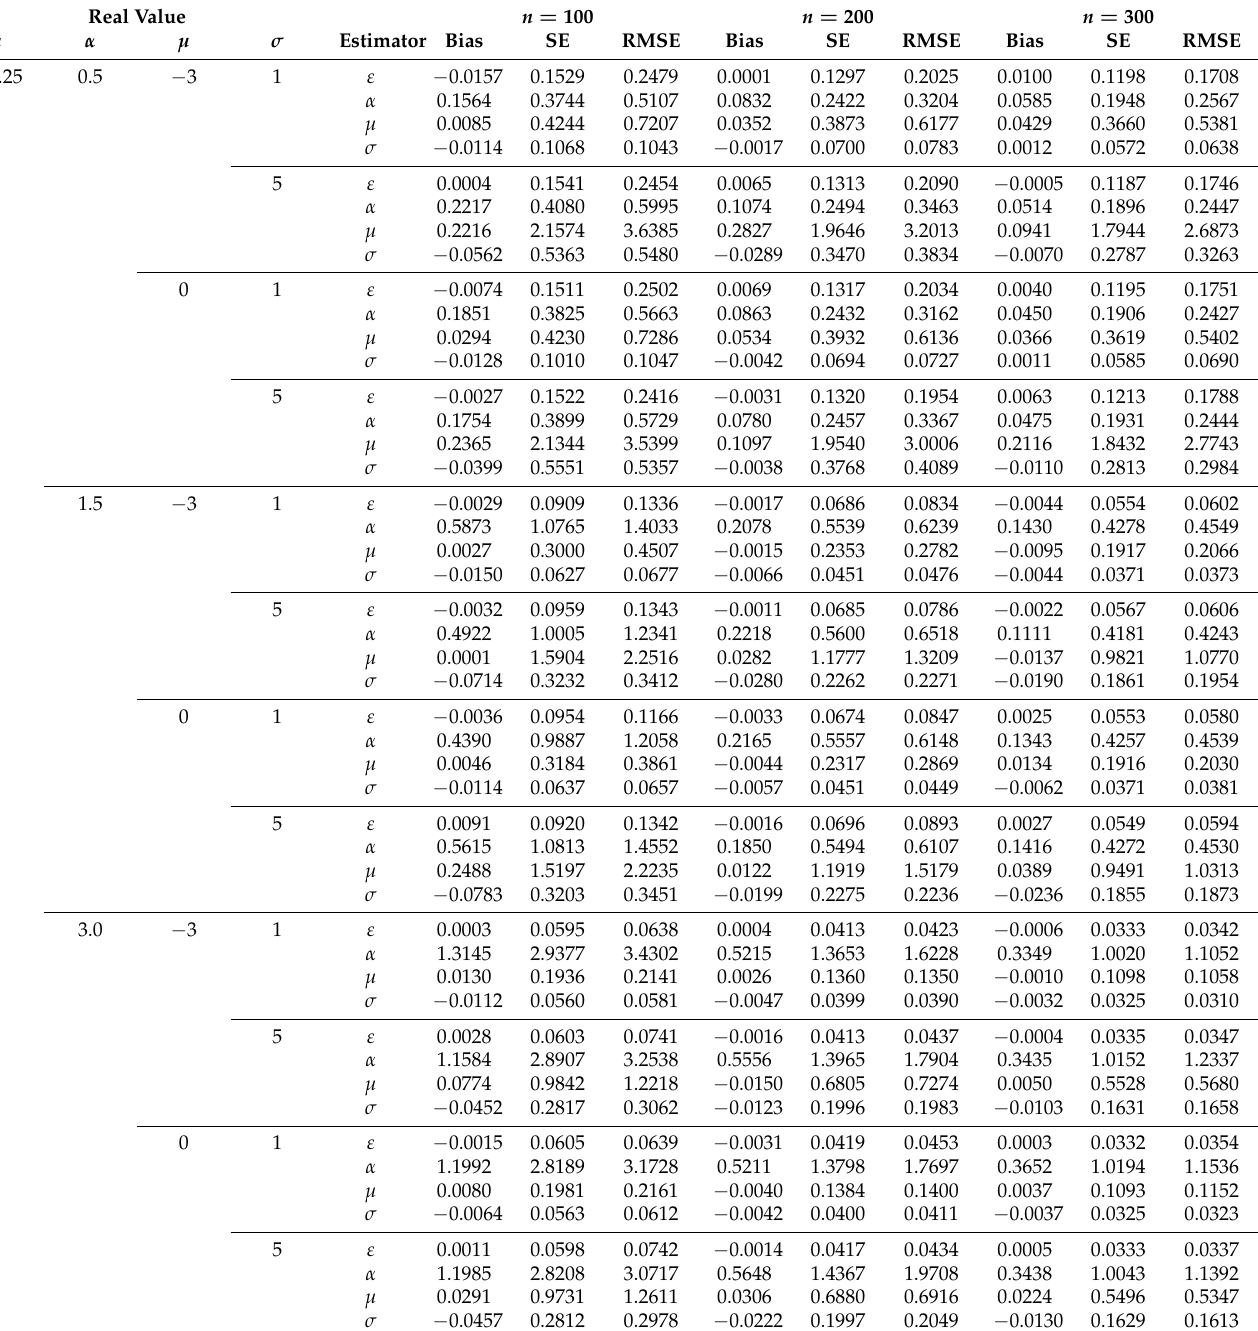
Table 2. Recovery parameters for the ML estimators in the BESN: case ε = −